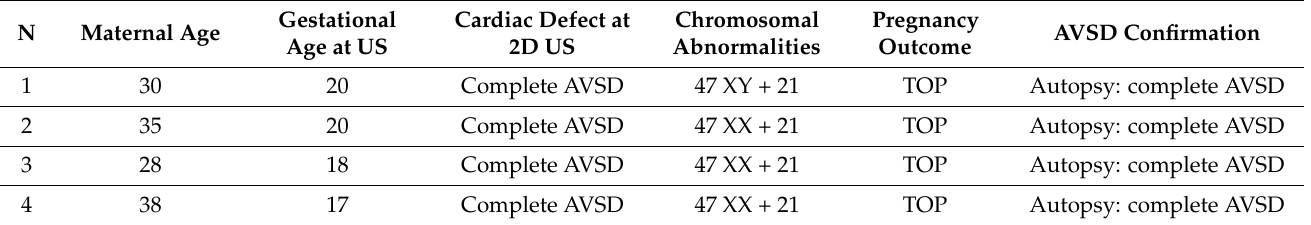
Table 1. Clinical features and pregnancy outcomes of patients with fetal atrioventricular septal